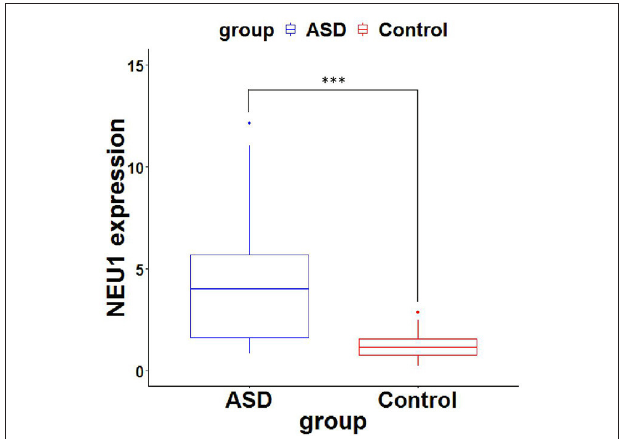
FIGURE 2 | Receiver operating characteristic (ROC) curve between clinical sensitivity and specificity for every possible cut-off. ROC curves of ASD and control with NEU1 expression. AUC was 0.868 ( P < 0.0001), sensitivity was 73.81% and specificity was